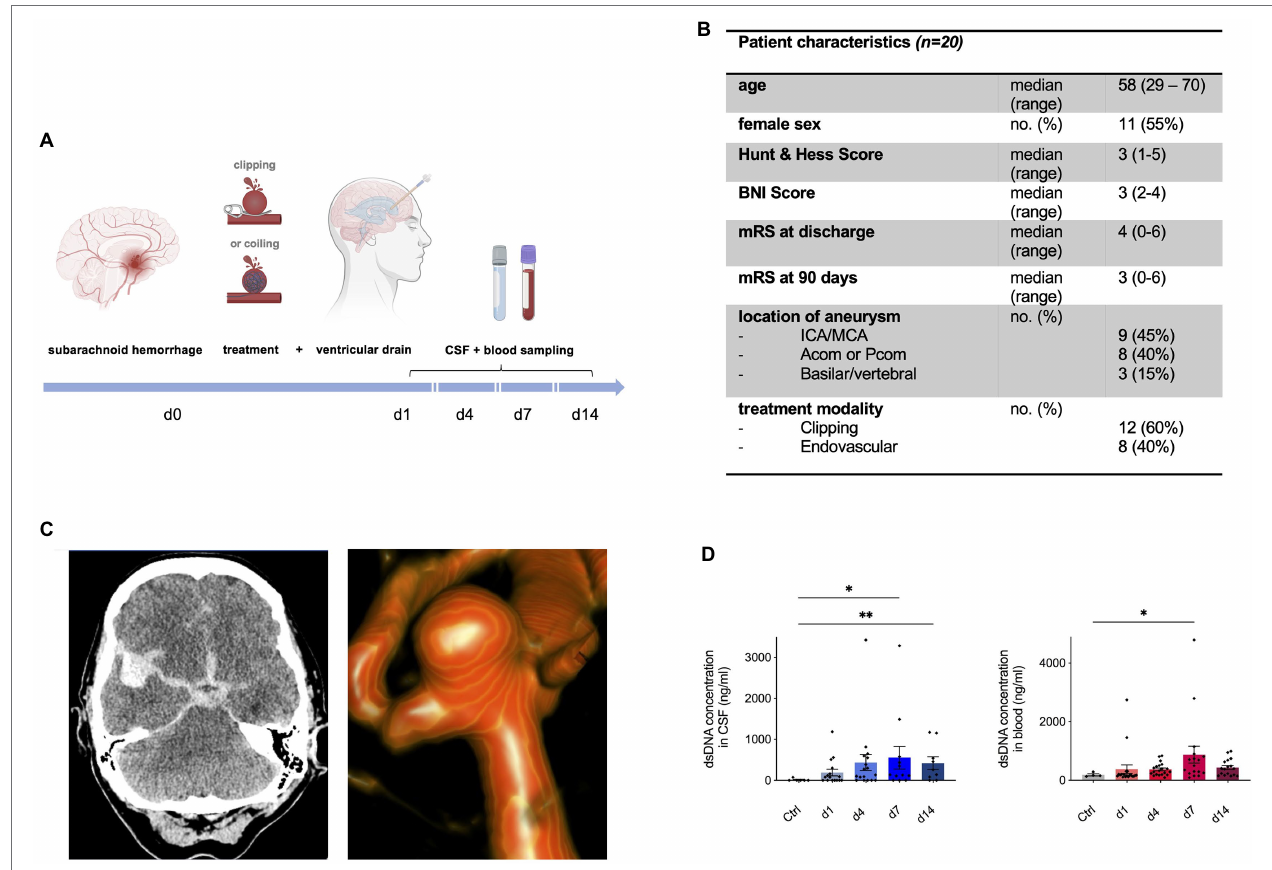
FIGURE 3 | Neutrophil extracellular traps are increased in human cerebrospinal spinal fluid (CSF) and peripheral blood after aneurysmal SAH. (A) Study protocol for collection of CSF and Ethylene Diaminetetraacetic acid (EDTA) blood; patients with aneurysmal SAH received either microsurgical clipping or endovascular intervention (coiling) with placement of an extraventricular drain (EVD). In the course of 14 days, CSF and peripheral blood were collected in a prospective manner. (B) Overview of patient characteristics. (C) Illustrative cases of SAH. CT imaging shows hyperdense blood collection in subarachnoid space and in the right sylvian fissure of a 55-year old patient who experienced SAH from a right-sided MCA aneurysm who underwent microsurgical clipping (left). 3D reconstruction of angiogram showing an ACom aneurysm of a 59-year old patient who was further treated via coiling. (D) Double-stranded DNA (dsDNA) concentration in CSF and peripheral blood of control patients and SAH patients shows peak on day 7 after bleeding onset. Acom, anterior communicating artery; BNI score, barrow neurological institute score; CSF, cerebrospinal fluid; ICA, internal carotid artery; MCA, middle cerebral artery; mRs, modified Rankin score; and Pcom, posterior communicating artery. * p < 0.05 and ** p <